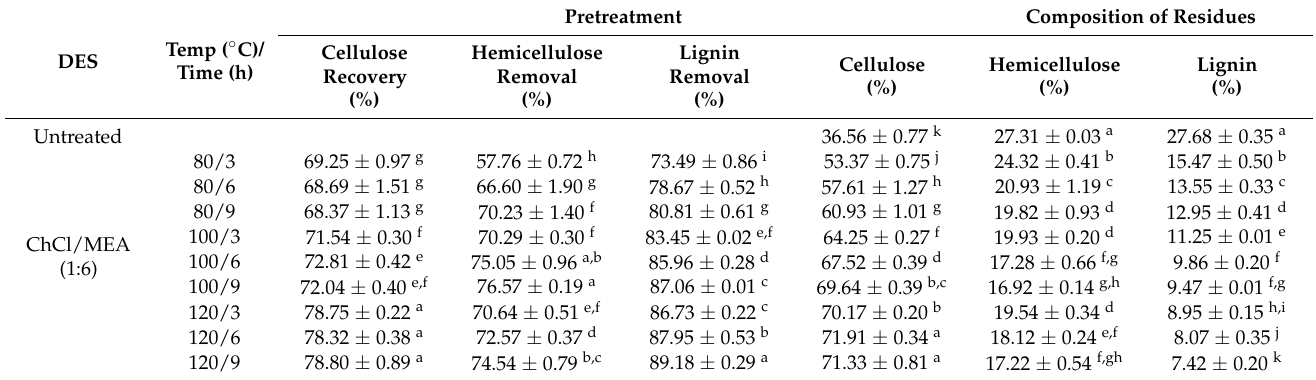
Table 2. Effects of the temperatures and time on the pretreatment of sugarcane leaves at a 1:16 substrate to DES solution ratio using 1:6 molar ratio of ChCls/MEA as